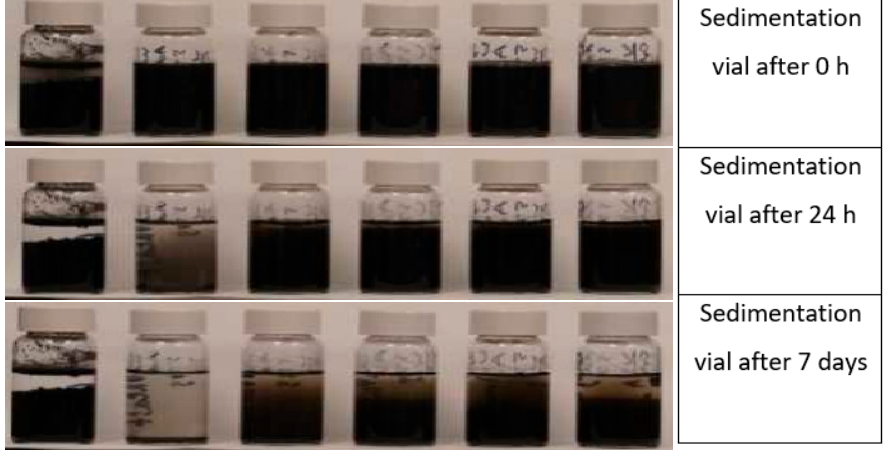
Figure 3. Effect of the presence of WRA to the dispersion of graphene sedimentation at different times; graphene sedimentation jars with WRA-to-GNPs ratios of 0, 1, 1.5, 2, 2.5 and 3 from left to right. Reproduced with permission from [78], Ph.D. Thesis, University of Illinois, 2014.